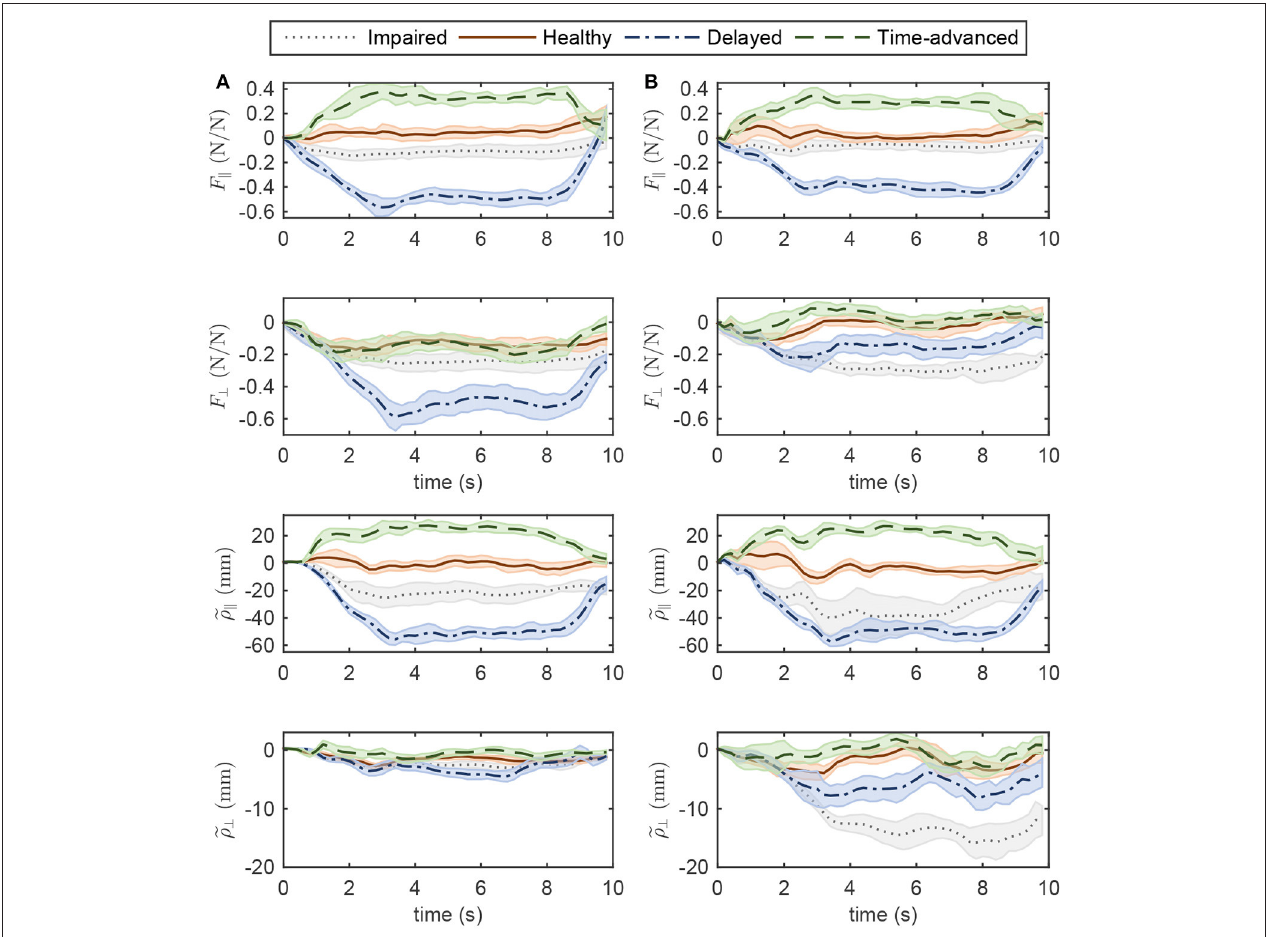
FIGURE 7 | Operational space normalized interaction force and position error in four modes of experiments while controlling the robot with (A) OIC, (B) SOIC. The shaded area denotes twice the standard deviation at each instance of